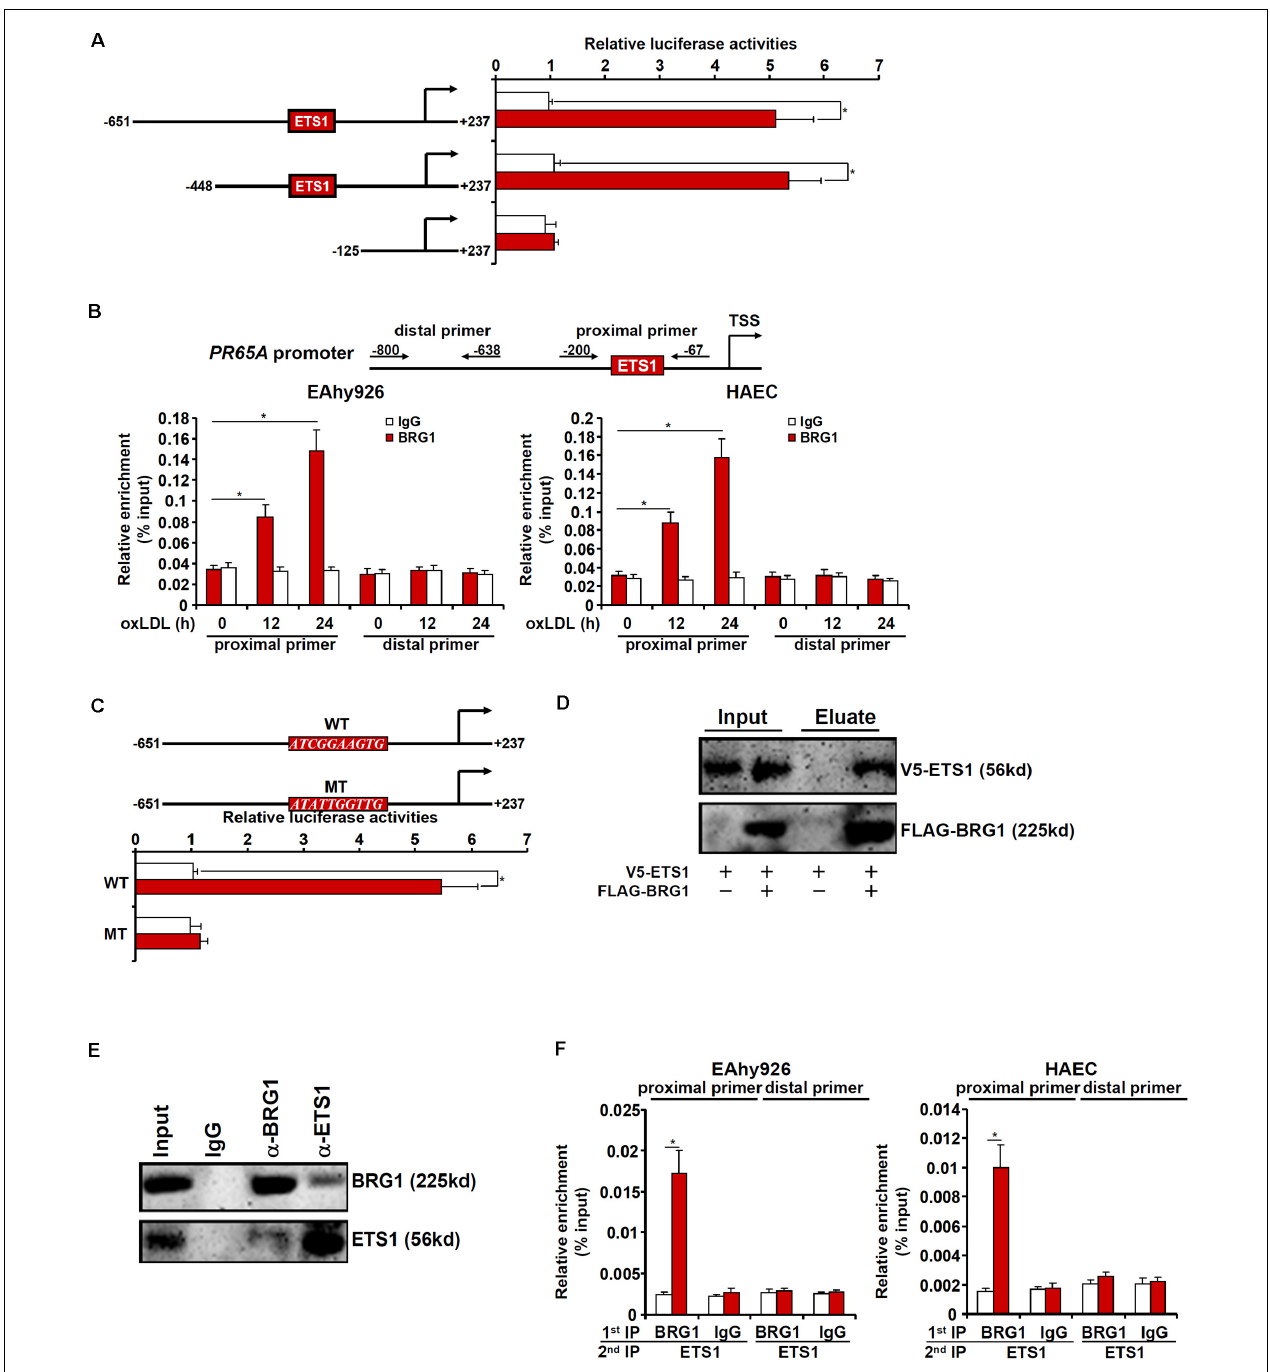
FIGURE 5 | BRG1 interacts with ETS1 to regulate PR65A transcription. (A) PR65A promoter-luciferase constructs were transfected into EAhy926 cells with or without BRG1 followed by treatment with oxLDL (10 µ g/ml). Luciferase activities were normalized by protein concentration and GFP fluorescence. (B) EAhy926 cells and HAECs were treated with oxLDL (10 µ g/ml) and harvested at indicated time points. ChIP assays were performed with anti-BRG1 or IgG. (C) Wild type and mutant PR65A promoter-luciferase constructs were transfected into EAhy926 cells with or without BRG1 followed by treatment with oxLDL (10 µ g/ml). Luciferase activities were normalized by protein concentration and GFP fluorescence. (D) FLAG-tagged BRG1 and V5-tagged EST1 were transfected into HEK293 cells. Immunoprecipitation was performed with anti-FLAG. (E) Nuclear lysates extracted from EAhy926 cells were immunoprecipitated with anti-BRG1. (F) EAhy926 cells and HAECs were with oxLDL (10 µ g/ml) for 24 h. Re-ChIP assays were performed with indicated antibodies. * p < 0.05.